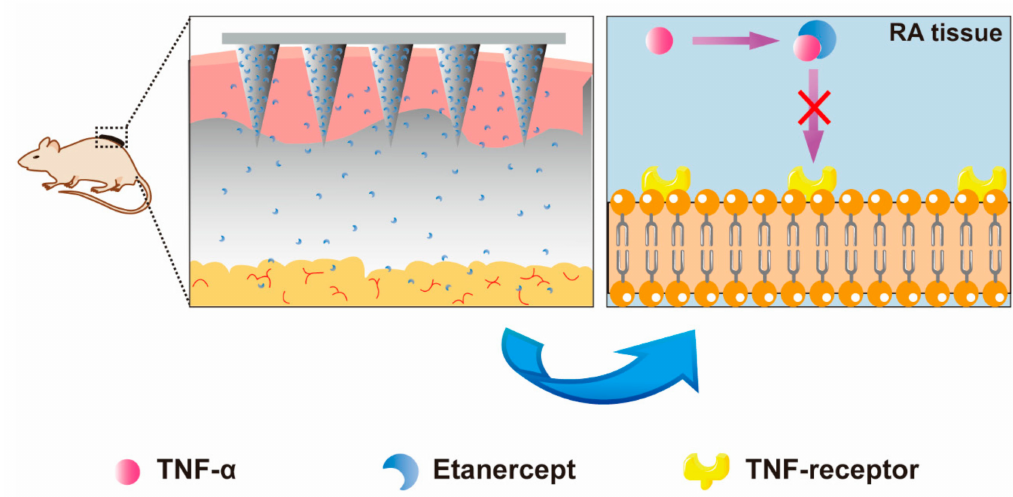
Figure 1. Schematic illustration of the concept. After the application of microneedle system (MN) on the dorsal skin of mice, etanercept (EN) is released from MN and absorbed by tissue blood capillary. In the arthritis tissue, EN takes e ff ects by blocking the binding of TNF- α and TNF